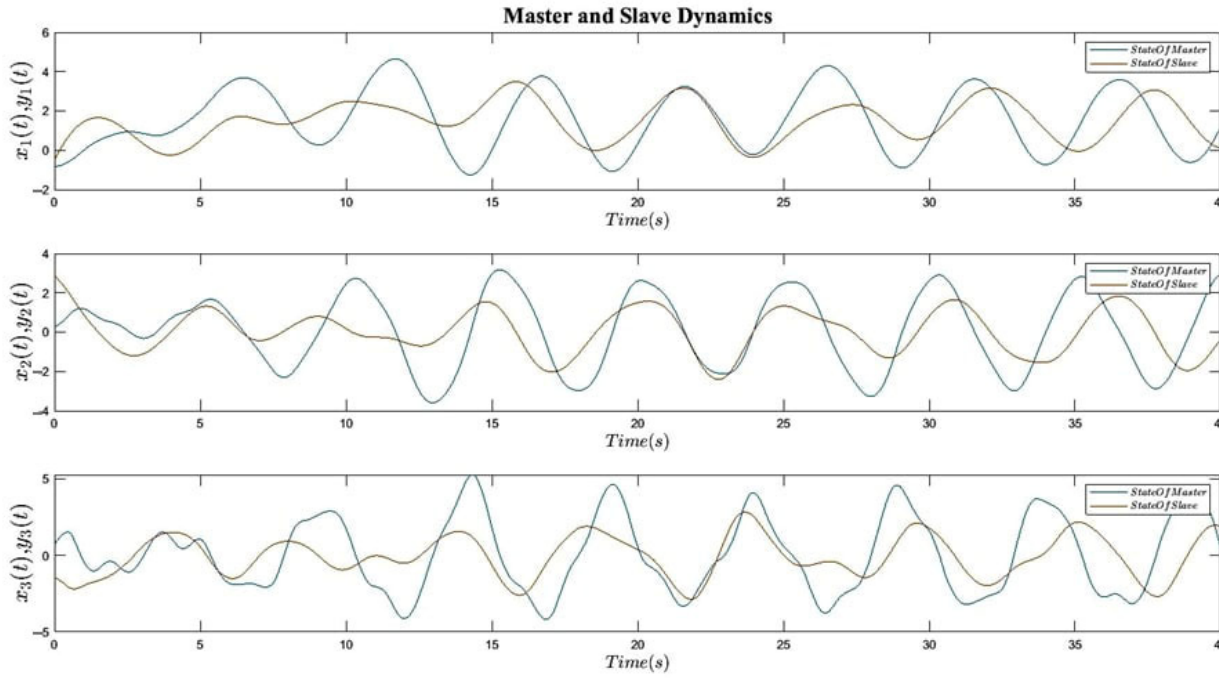
Figure 2. Behavior of master and slave system states without applying the control signal.